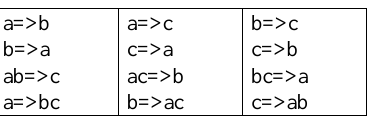
Table 2. All the 12 association